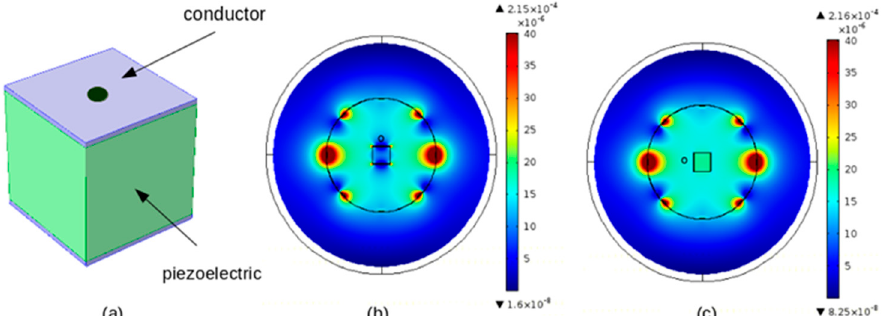
Figure 5. MRI RF magnetic field distribution in the case of the introduction of a piezoelectric with electrodes ( a ) material configuration ( b ) field distribution with electrodes perpendicular to the field ( c ) field distribution with electrodes parallel to the field [45].